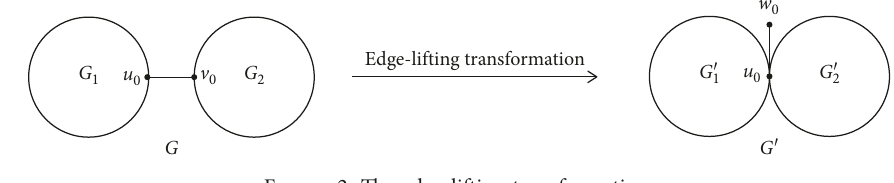
Figure 2: The edge-lifting transformation.